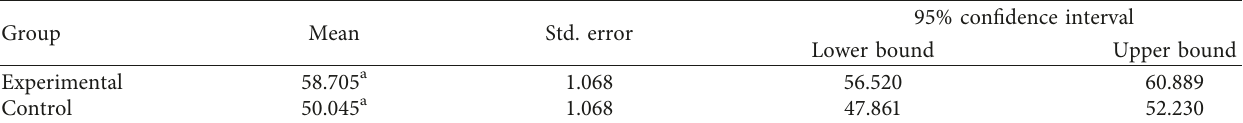
Table 7: Estimated marginal means.